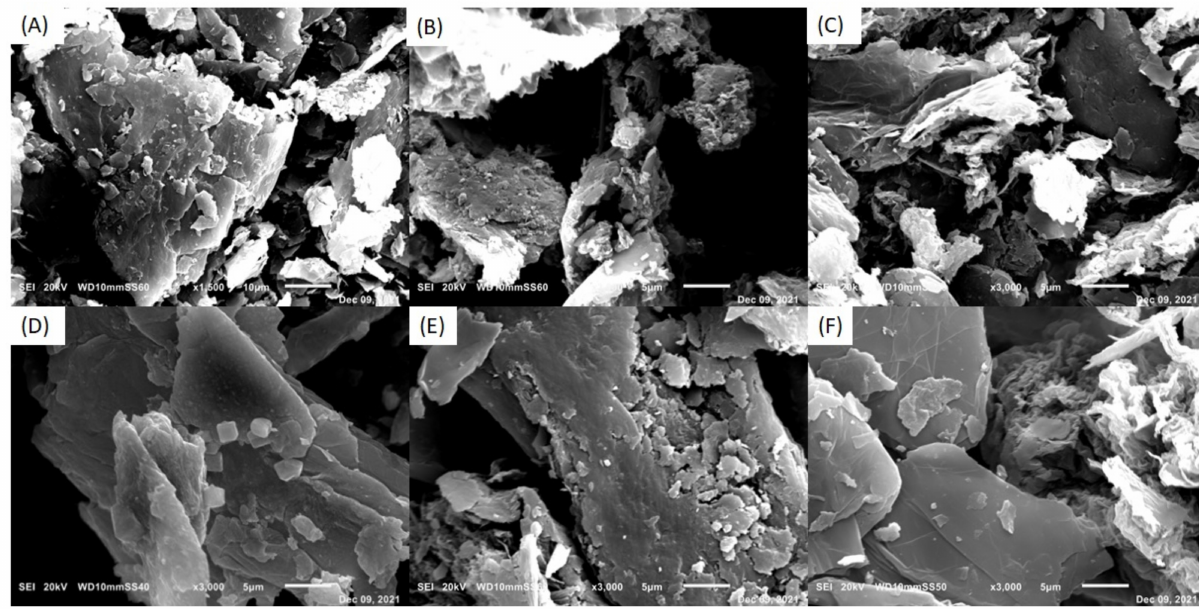
Figure 6. SEM micrographs (3000x) of graphene oxides: ( A ) GO1, ( B ) GO2, ( C ) GO3, ( D ) GO1-GPTMS, ( E ) GO2-GPTMS, and ( F )